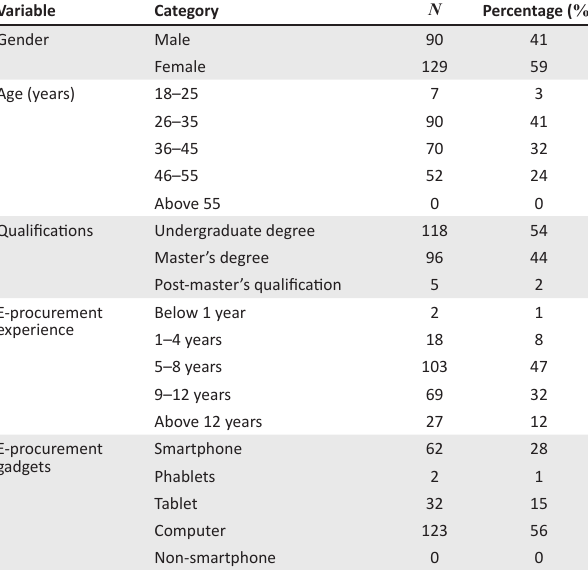
TABLE 1: Demographic profile of the respondents.